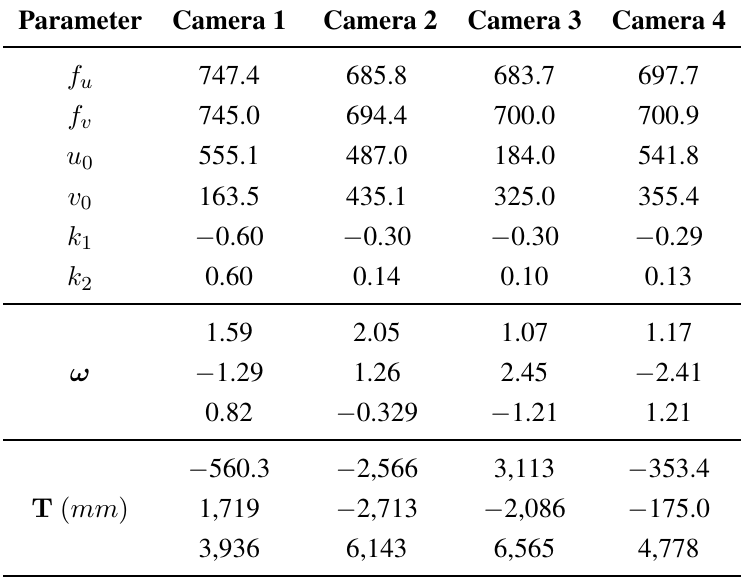
Table 1. Calibrated parameters of the intelligent space’s